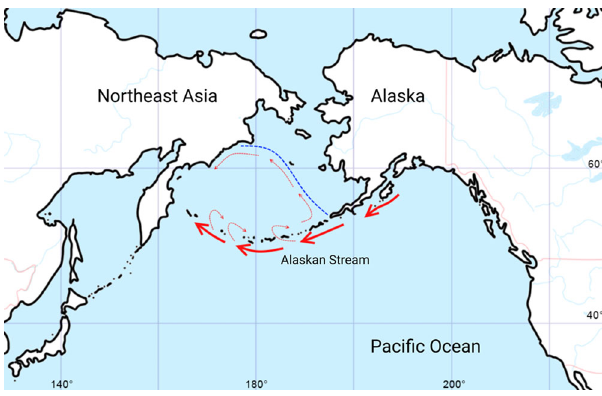
Fig. 1 Simpli fi ed representation of the sea current con fi guration in North Paci fi c region. The blue dashed line schematically represents the Last Glacial Maximum coastline and the red arrows show the Alaskan Stream, which enters the Bering Sea, then forms the Aleutian North Slope (marked by red dashed arrows) current which fl ows into the East Kamchatka current (modi fi ed from Detlef et al. 9